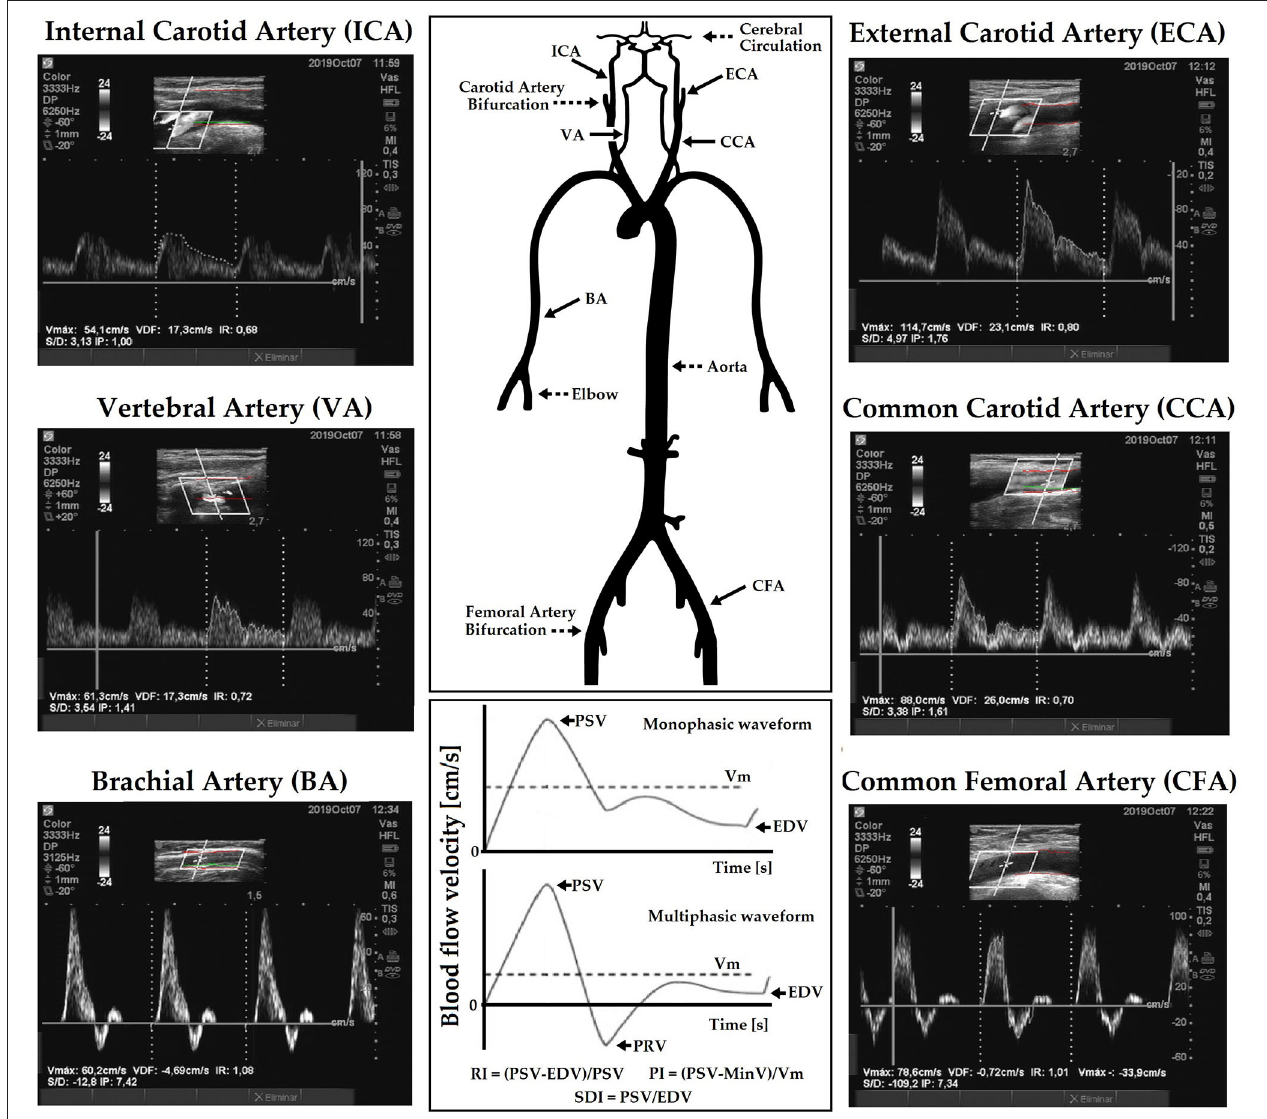
FIGURE 1 | Diagram showing arterial blood flow velocity (BFV) waves recordings and resistive (RI), pulsate (PI), and systo-diastolic index (SDI) calculus, for monophasic and multiphasic waves. Multiphasic waves cross the zero-flow baseline (0 cm/s) and contain both forward and reverse velocity components (e.g., common femoral artery, CFA; brachial artery, BA). Monophasic waves do not cross the zero-flow baseline (e.g., common carotid artery, CCA; Internal carotid artery, ICA) and reflect blood that flows in a single direction during the cardiac cycle. High-resistive waves have a sharp upstroke and a brisk downstroke and may be either multi (e.g., common femoral artery, CFA) or monophasic (e.g., external carotid artery, ECA). Low-resistive waves are monophasic, and contain a prolonged downstroke in the late systole with the continuous forward flow throughout diastole without an end-systolic notch (e.g., ICA). There is a “hybrid” waveform that is monophasic but has features of both high and low resistivity as it contains both brisk downstroke but also continuous forward flow throughout diastole (e.g., CCA).